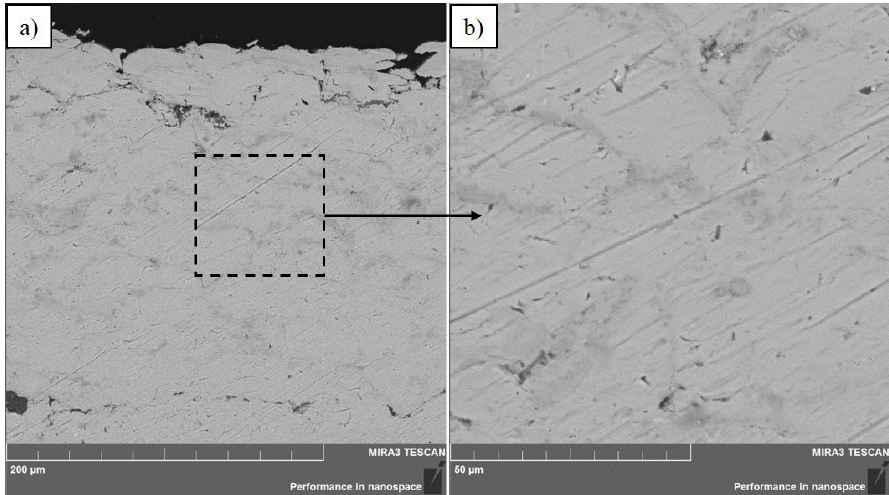
Figure 3. Cross-sectional microstructure of Ti1 coating. Microstructure of ×1000 ( a ) and ×3000 ( b ).